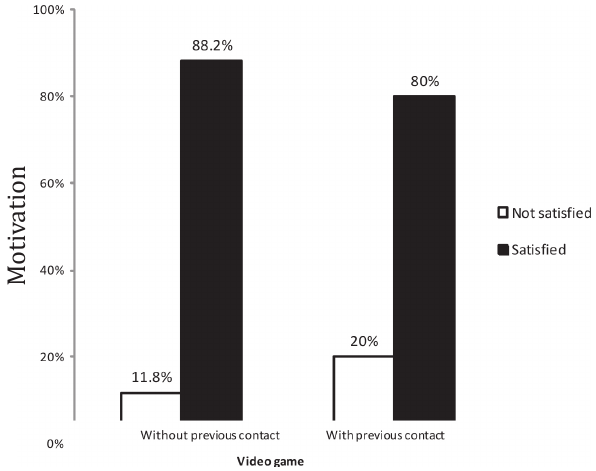
Figure 2 - Relationship between motivation provided by Ikapp and prior contact with video